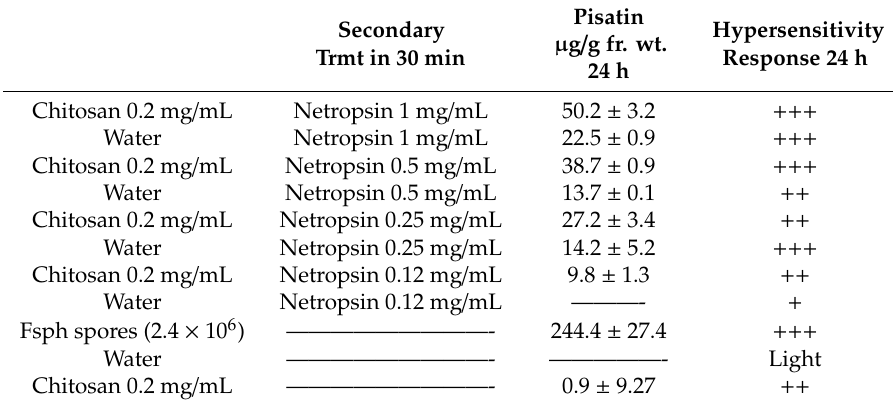
Table 3. Pisatin production by netropsin concentrations following pretreatment with low chitosan treatments, 20 µ L volumes of all treatments of pea endocarp tissue per pod half. Hypersensitive response was estimated arbitrarily by + . Pisatin production was quantitated by UV spectrophotometer at 309 nm.